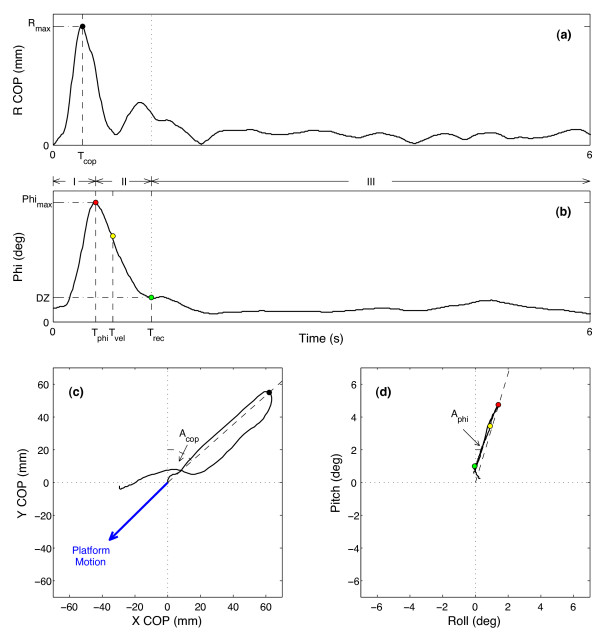
Sample data from a 225° perturbation. (a) Magnitude of R COP and (b) Phi are shown as functions of time, indicating peak values (Rmax, Phimax), peak times (Tcop, Tphi), recovery time (Trec), and time to peak recovery velocity (Tvel). DZ indicates the degree of tilt within which no tactors are activated. The three stages of the trajectory are marked as I, II, and III for panels (a) and (b). (c) X and Y components of COP are shown in a bird’s-eye view with the peak time (black filled circle) and angle (dashed line), as well as the platform motion (blue arrow). (d) A/P and M/L components of tilt are shown in a bird’s-eye view with the peak time (red circle) and angle (dashed line), Tvel (yellow filled circle), and Trec (green filled circle).